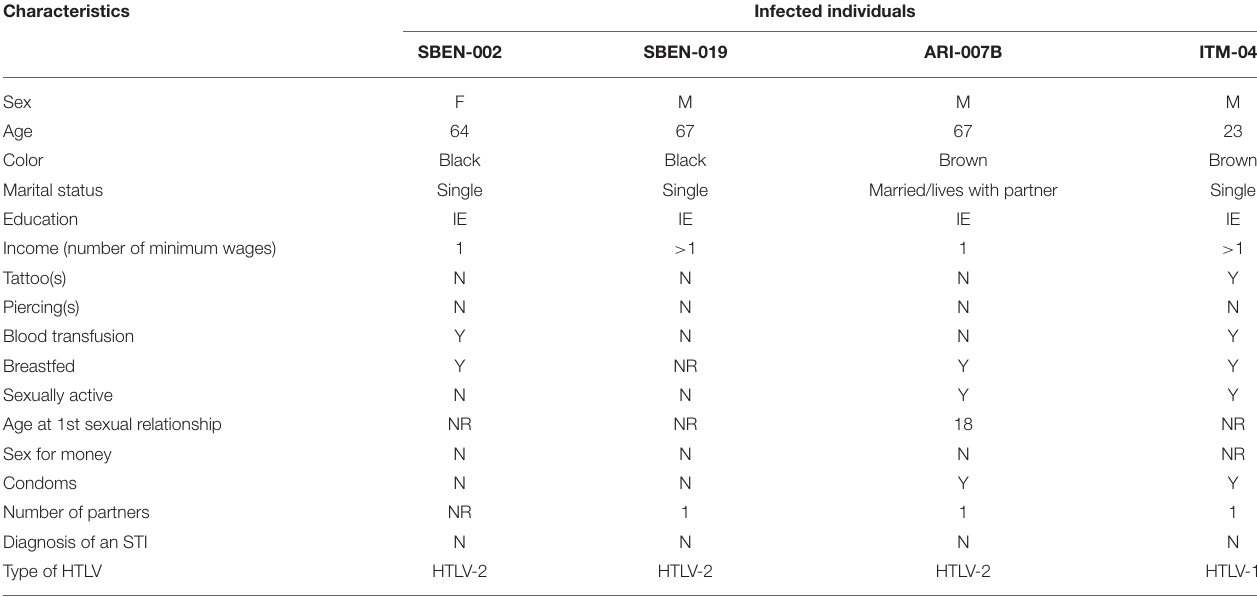
TABLE 3 | Sociodemographic and behavioral characteristics of individuals with confirmed HTLV-1 and HTLV-2 infection.